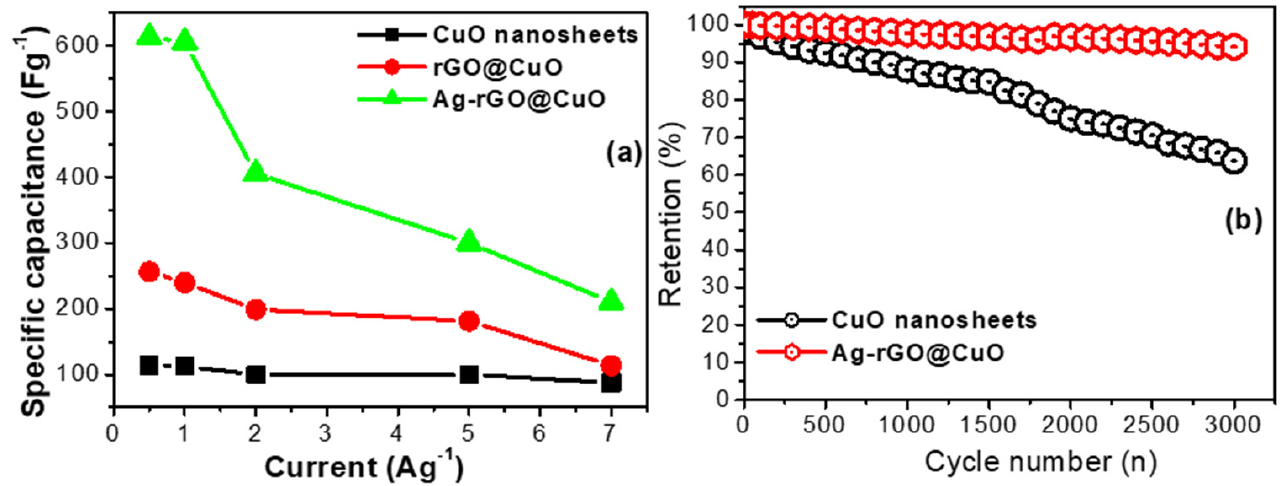
Figure 10. ( a ) Calculated specific capacitance of pure CuO nanosheets, rGO@CuO, and Ag-rGO@CuO at different current densities, ( b ) cycling stability graph of the CuO nanosheets and Ag-rGO@CuO nanocomposite.